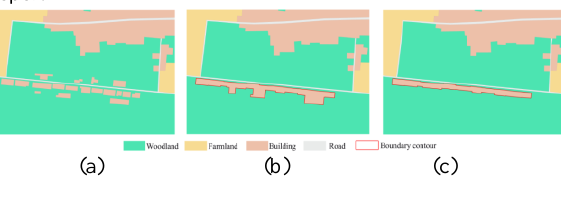
Figure 8. Comparison of merging results for the simple linear pattern. (a) Original data; (b) result of mixed integer programming method; (c) result of the method proposed in this paper.